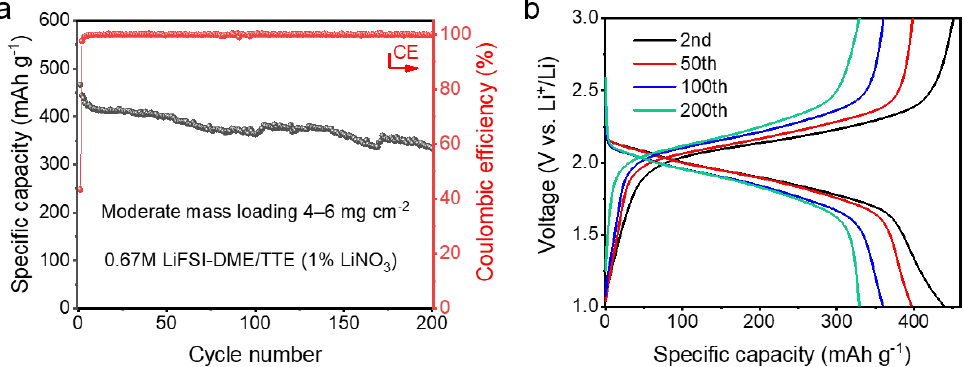
Figure 3. ( a ) Cycling stability; ( b ) Galvanostatic current charge – discharge curves of high mass load- ing and lean electrolyte Li||pPAN/SeS 2 half − cells.